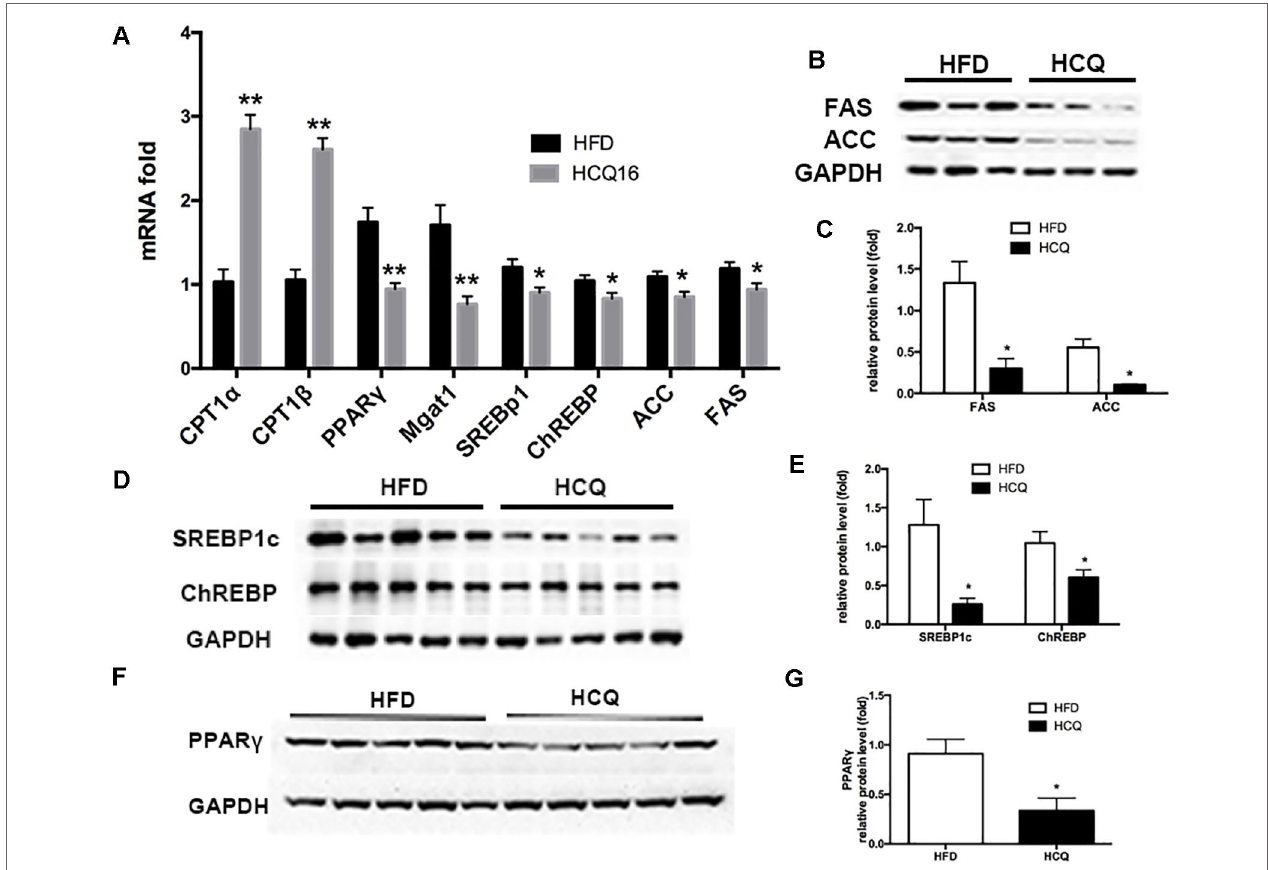
FIGURE 6 | HCQ regulated mRNA and protein expression in liver tissues. The (A) mRNA and (B–G) protein expression pertaining to lipometabolism as CPT1 α ,